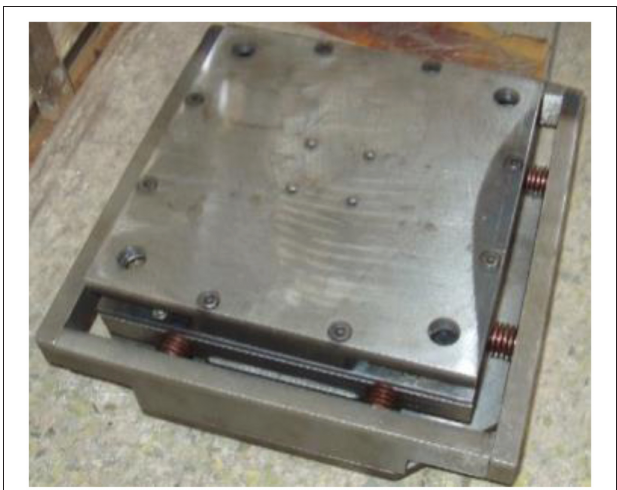
FIGURE 7 | Photo of the 2-D plate-type MRD.